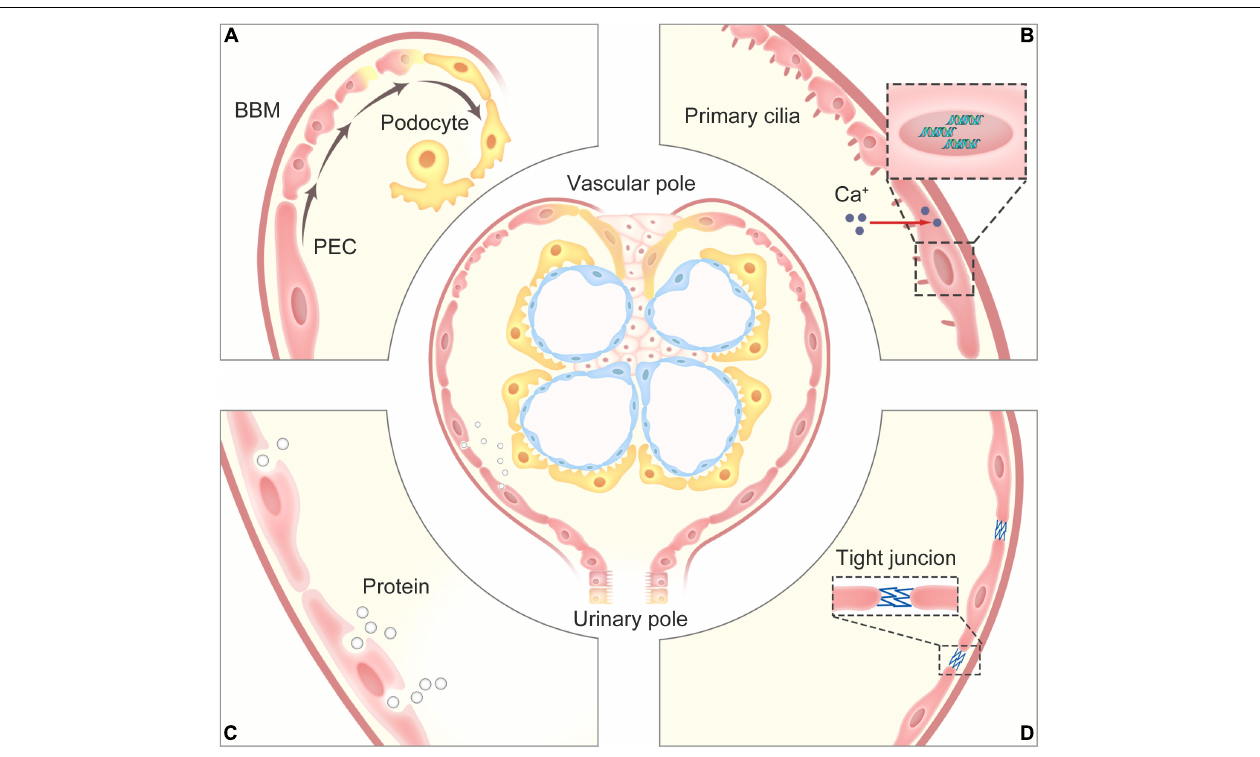
FIGURE 1 | The physiological functions of PECs. (A) PECs serve as a potential precursor for podocytes, which can progressively proliferate and differentiate into podocytes for restore and maintain the number of podocyte within the glomerular tuft. (B) The primary cilia on the surface of PECs can perceive the change of flow from the glomerular filtrate to promote the increase in intracellular calcium that affects gene expression, and the contractility of PECs may regulate the pressure in the Bowman’s capsule to adjust glomerular filtration. (C) PECs can take up proteins via an undefined endocytosis mechanism in cases of glomerular ultrafiltrate overload. (D) PECs with their tight junctions form an impermeable barrier, prevents proteins in the glomerular ultrafiltrate in the Bowman’s space from exiting into the extraglomerular space. PECs, parietal epithelial cells; BBM, Bowman’s basement